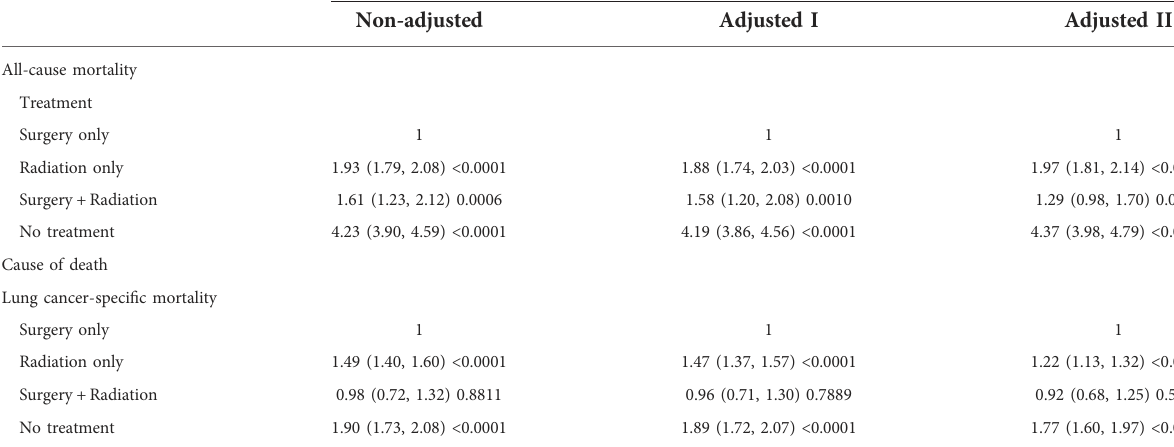
TABLE 3 Multivariate analysis of the association between treatment method and